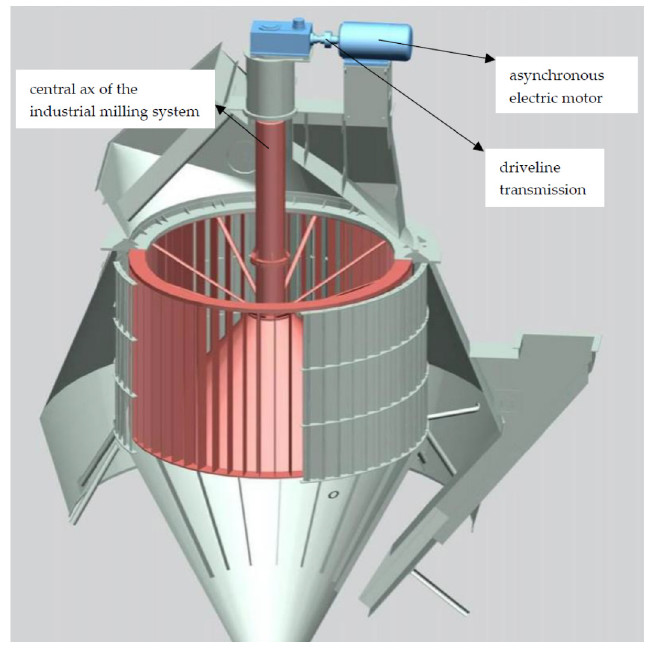
Figure 1. General schema of a heavy-duty industrial milling system.